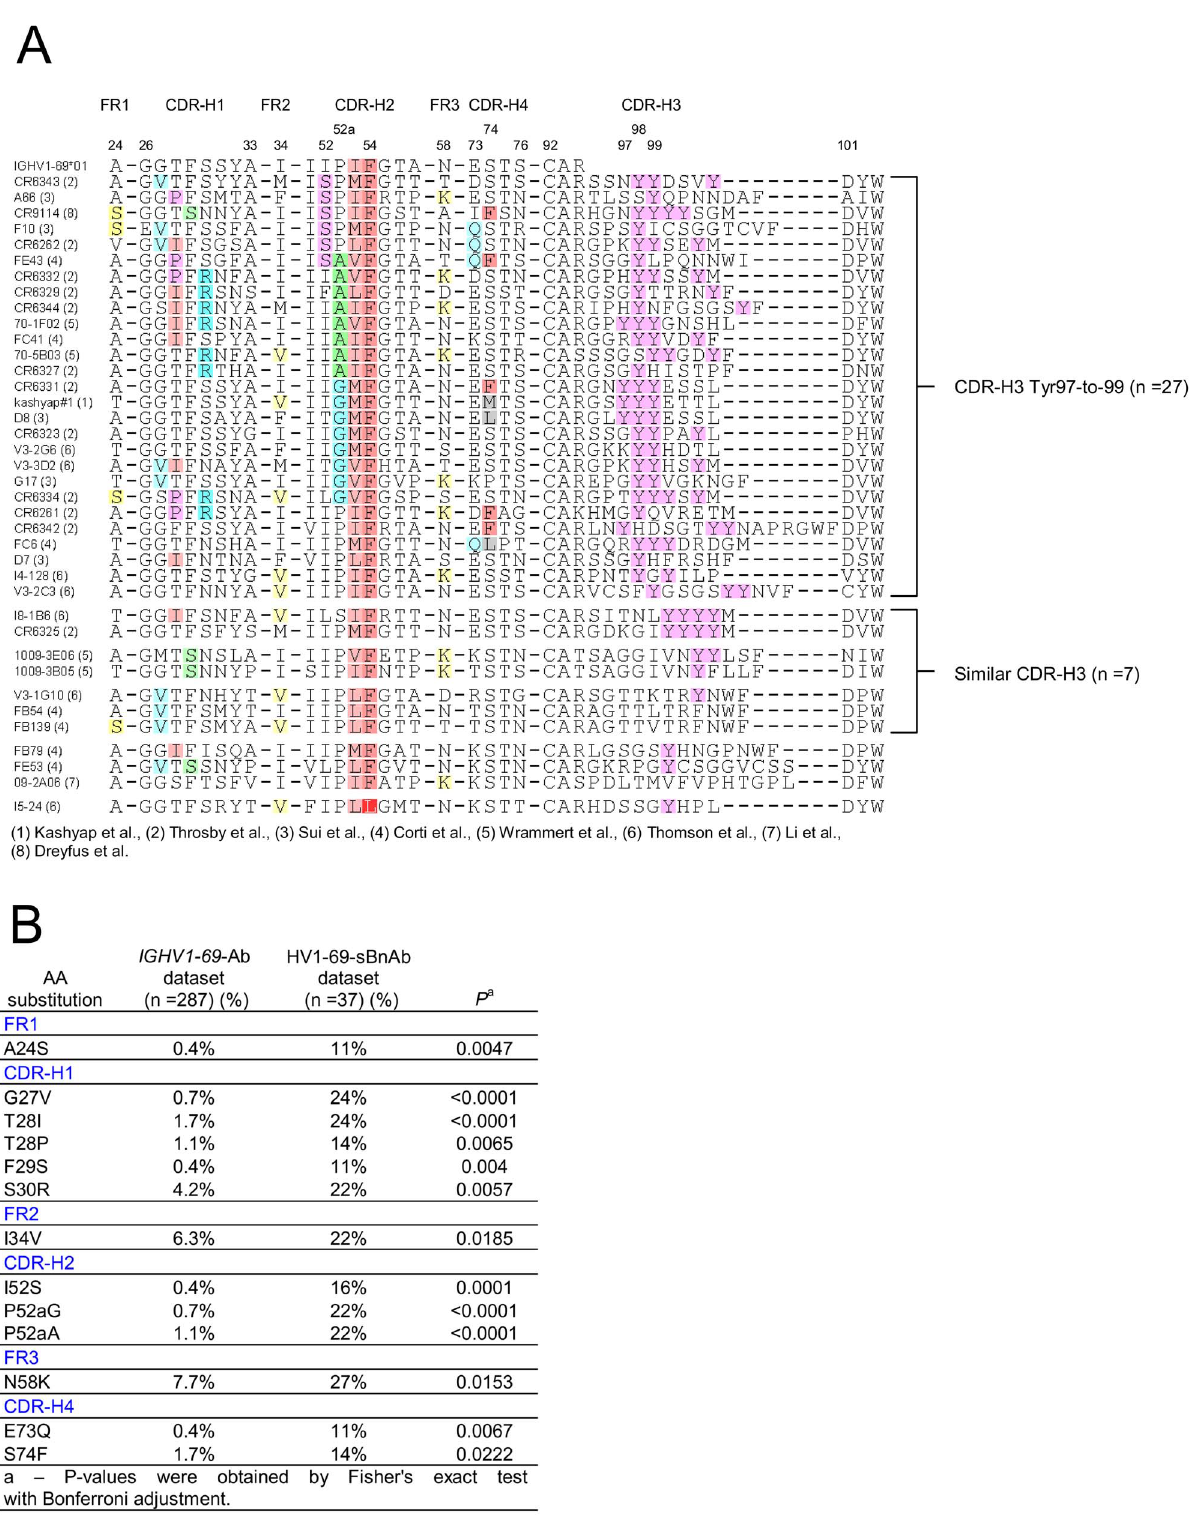
Figure 2. Characterization of HV1-69-sBnAbs VH domain. A ) Alignment of 38 published HV1-69-sBnAbs is shown with highlights referring to hydrophobic residues at position 53 (light plum), the conserved Phe54 (dark plum), the occurrence of CDR-H3-Tyr (pink) residues. Other highlights refer to panel B ), which describes the result of a Fisher’s exact test with Bonferroni adjustment that compared V-segment amino acid substitutions diversity and frequency of the 37 51p1 allele related HV1-69-sBnAbs with that of a reference IGHV1-69 51p1 allele related Ab dataset. 13 amino acid substitutions were determined to uniquely associate with the HV1-69-sBnAb dataset (P , 0.05).